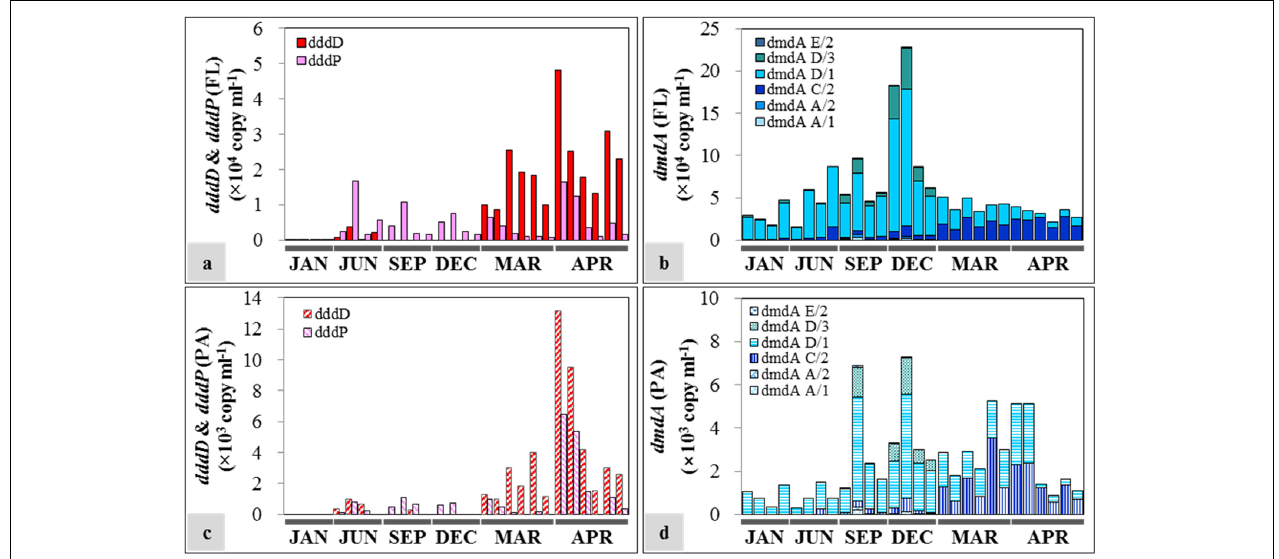
FIGURE 6 | Seasonal distribution of dimethylsulfoniopropionate (DMSP) degradation genes in free-living (FL) and particle-associated (PA) fractions: (a) dddD and dddP abundances in the FL fractions; (b) dmdA abundance in the FL fractions; (c) dddD and dddP abundances in the PA fractions; (d) dmdA abundance in the PA fractions. The sample IDs are shown in Table 1 . Each bar from left to right represents samples from the top to the bottom in Table 1 .